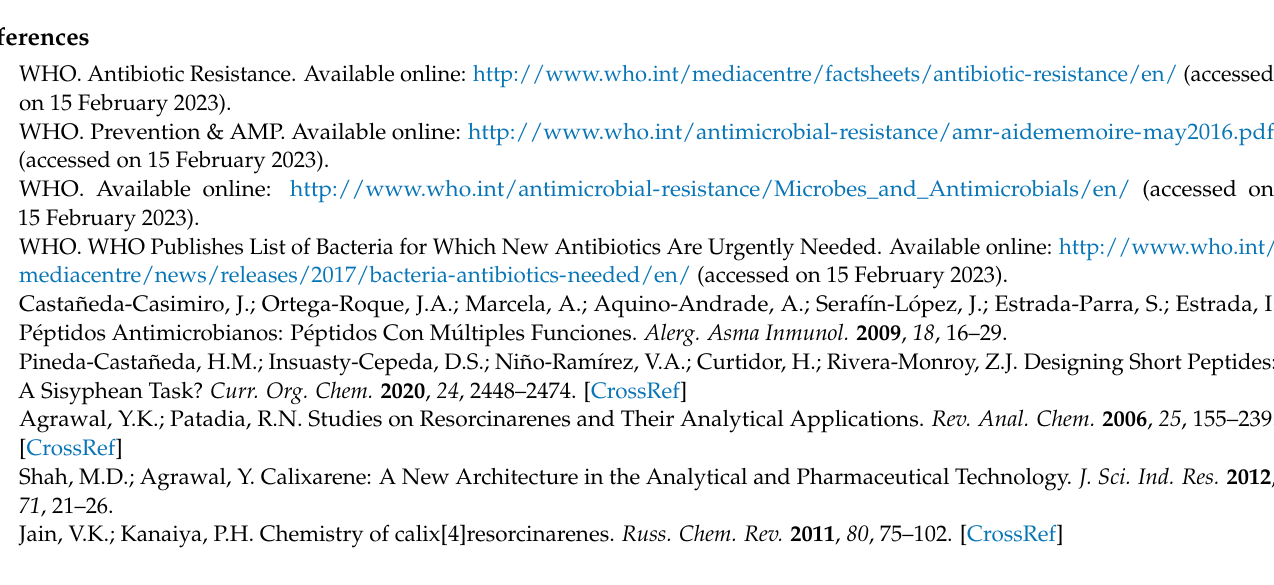
Figure S6: Chromatographic profiles of the peptide-resorcinarene conjugates (a) CTpH(F)-(AAC- (K)-RLLR) 4 ( rctt ), (b) CTpH(F)-(AAC-(K)-RRWQWR) 4 ( rctt ); Figure S7: HR-MS of the peptide- resorcinarene conjugates (a) CTpH(F)-(AAC-(K)-RLLR) 4 ( rctt ), (b) CTpH(F)-(AAC-(K)-RRWQWR) 4 ( rctt